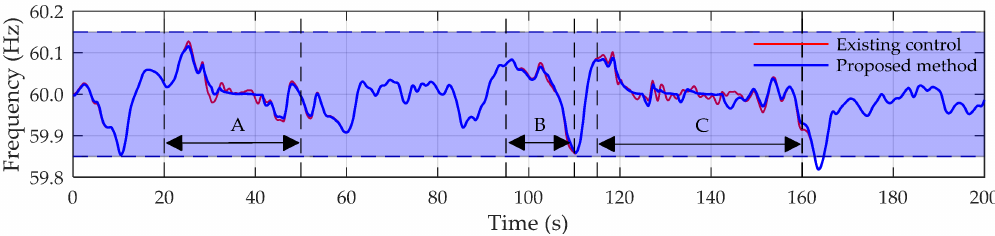
Figure 19. Effects of the proposal on the grid